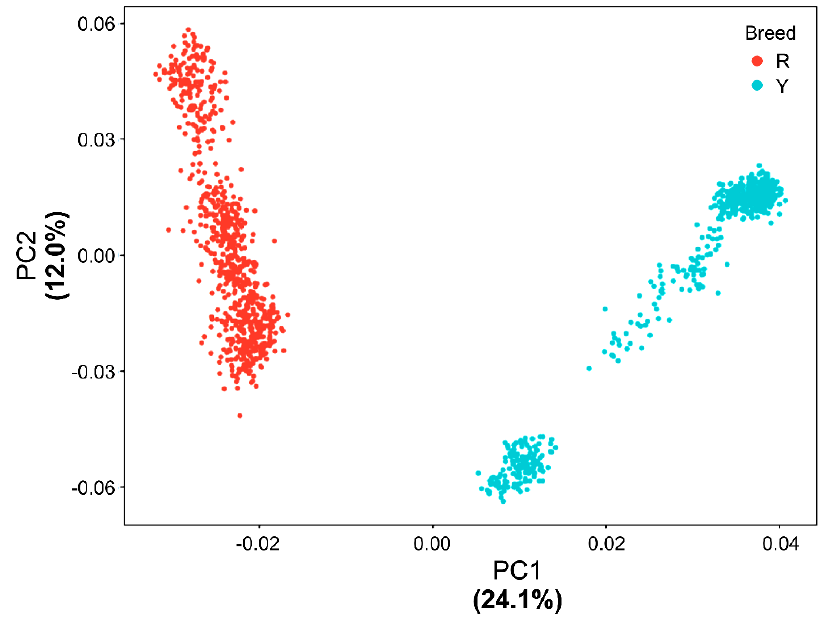
Figure 2. Population structure of two Korean native chicken (KNC) breeds based on the principal component (PC) analysis. Dots of different colors represent each individual from the two breeds (R: Red KNC; Y: Yellow KNC).